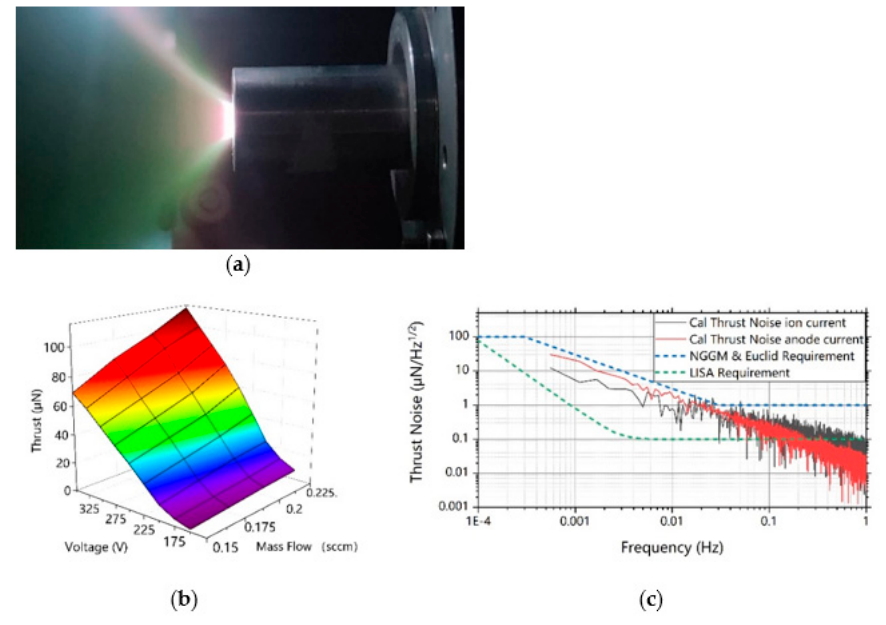
Figure 18. ( a ) The μ N-level cusped field thruster in HIT, and its performance on ( b ) thrust operation range and ( c ) thrust noise PSD.